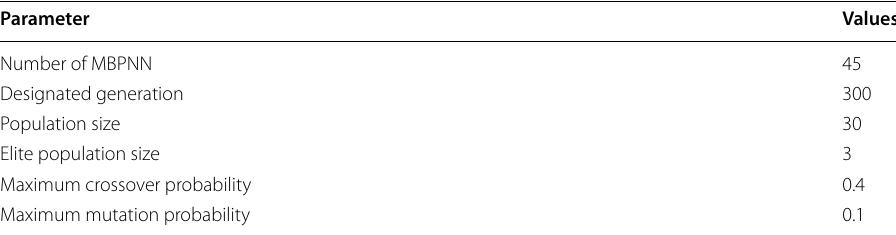
Table 4 Configuration of